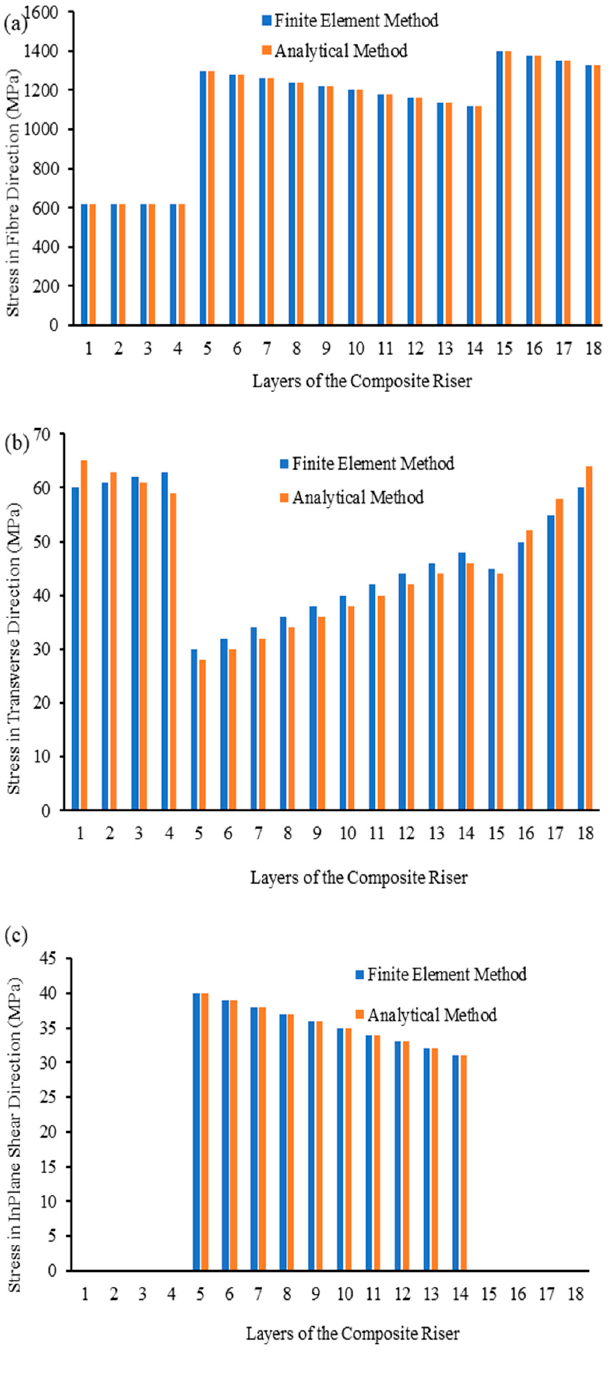
Figure 12. Result of composite riser model’s local design for AS4/PEEK utilising PEEK liner under burst case showing the axial, angled, and hoop reinforcements along ( a , d ) fibre, ( b , e ) transverse, and ( c , f ) in-plane shear directions for finite element method vs. analytical method.